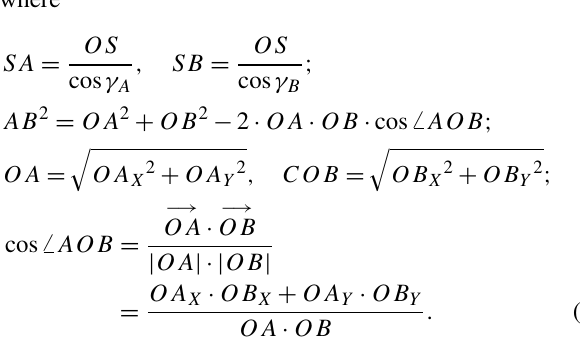
Table 6. Statistics of double star data for